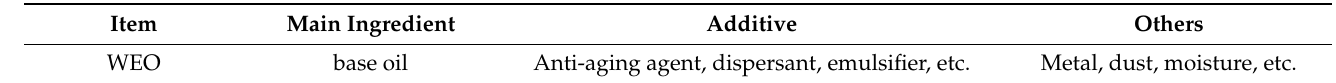
Table 2. Composition of waste engine oil.